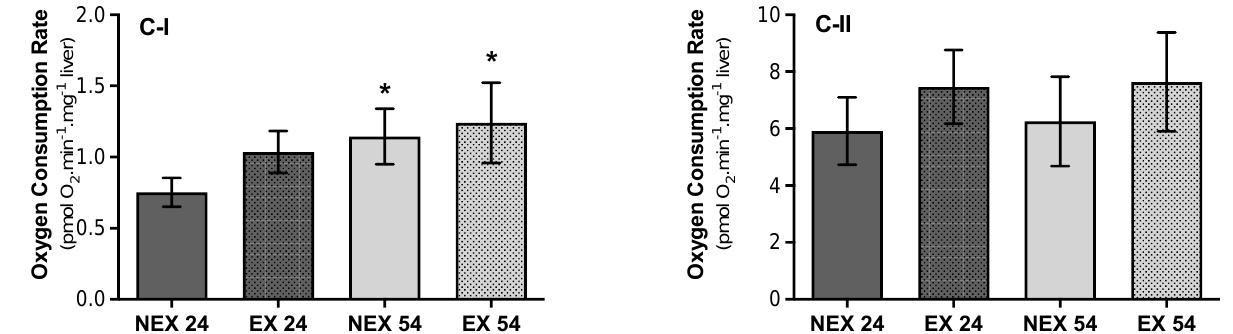
Figure 6. Effect of ageing and training in mitochondrial state 2 respiratory rates: Mitochondrial respiration measured, in liver homogenate, with specific substrates for complex I ( C-I ) and complex II ( C - II ). Oxygen consumption rates were measured after the adding of 10 mM pyruvate and 5 mM malate ( C-I ), and oxygen consumption was obtained with 10 mM succinate ( C-II ). Rotenone (0.5 μM) and antimycin A (5 μM) were added to determine the specific respiration of complexes I and II, as described in the Material and Methods section. Values are means ± SD ( n = 7), with two replicates. * p < 0.05 compared with NEX24; NEX24 (non-exercise young, sacrifice at 24 weeks of training), EX24 (exercise young, sacrifice at 24 weeks of training), NEX54 (non-exercise middle-age, sacrifice at 54 weeks of training), EX54 (exercise middle-age, sacrifice at 54 weeks of training).